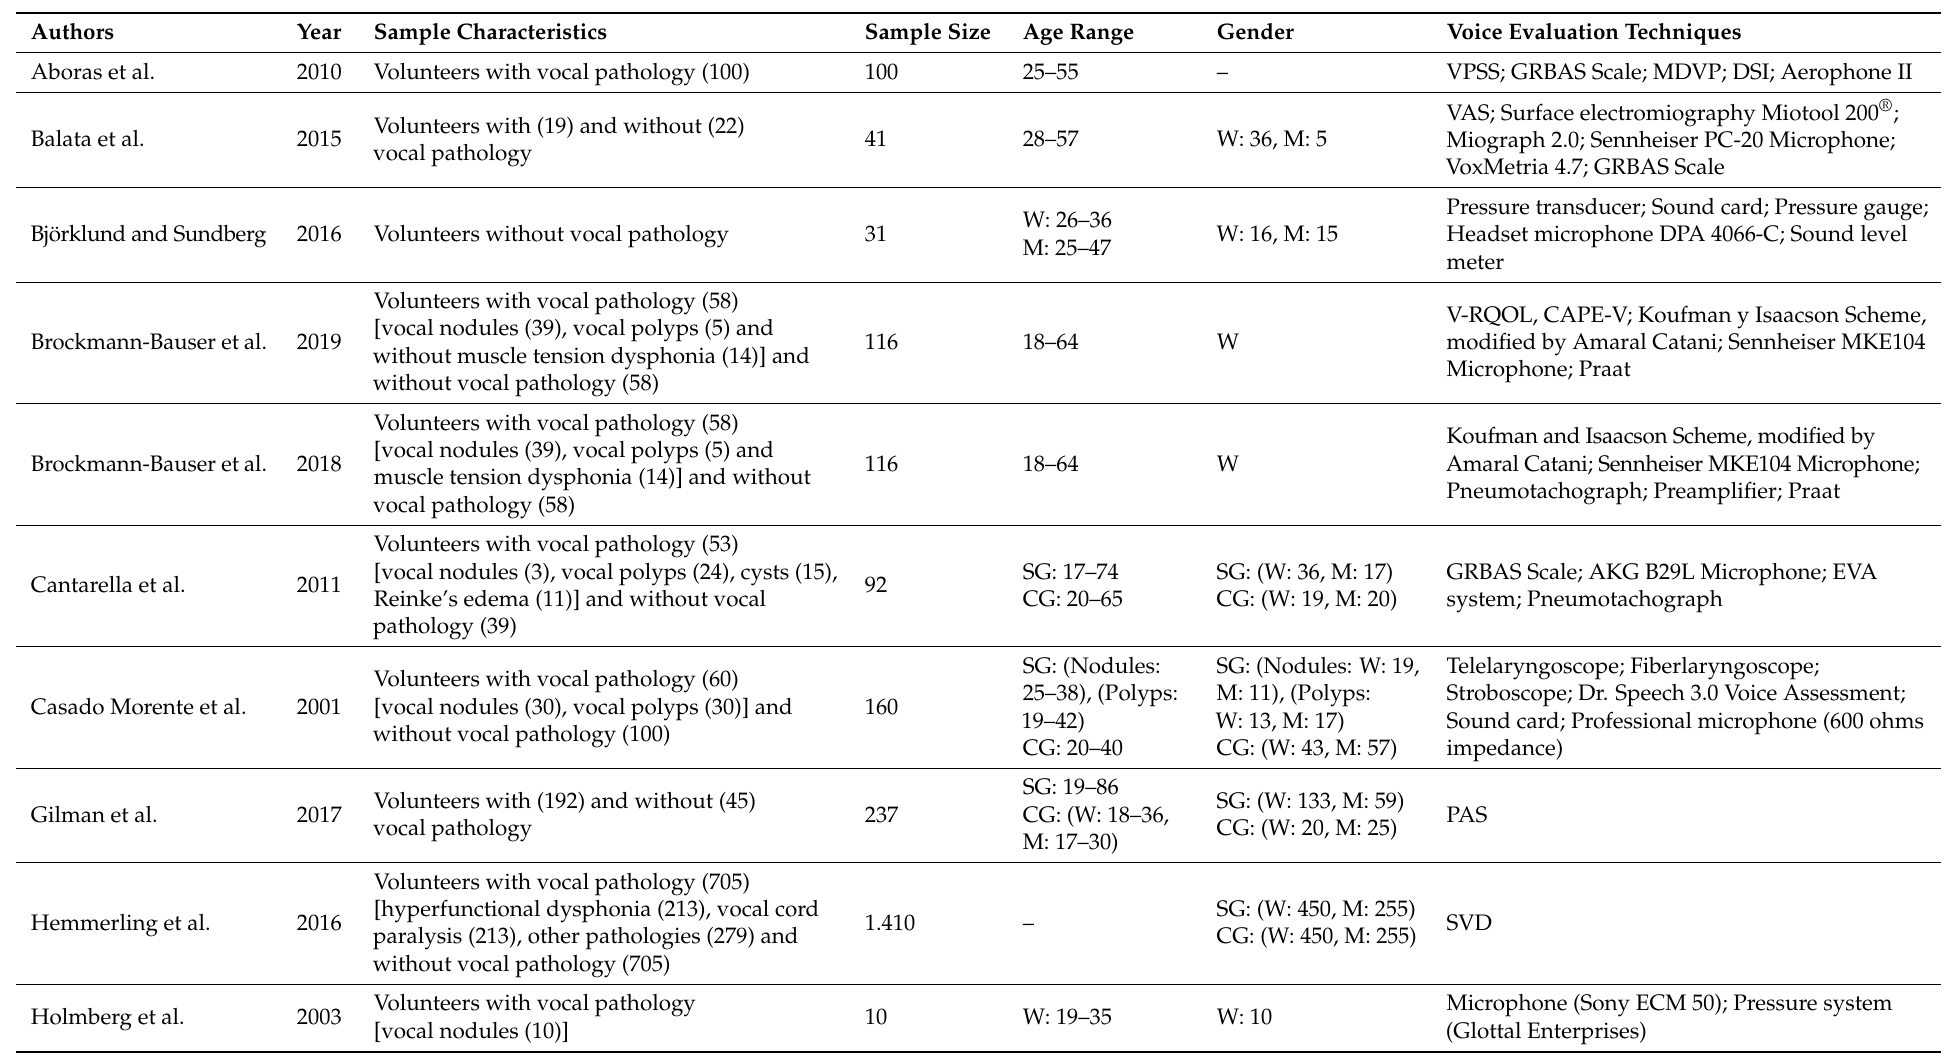
Table 1. Summary of the methodology of the selected